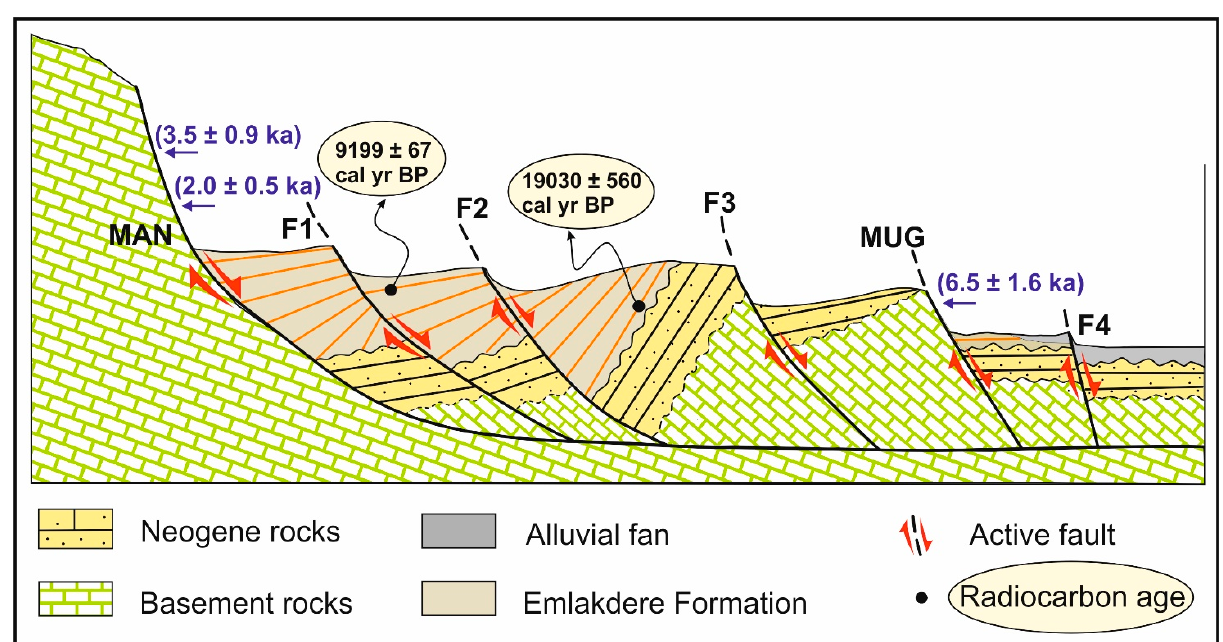
Figure 11. Simplified schematic sketch showing western Manisa Fault Zone and its synthetic faults displacing formations of various ages (Early-late Holocene). Note that in the cartoons the exact horizontal and vertical scales, vertical displacement values as well as thickness of sedimentary layers are disregarded. The approximate lateral distance between MAN and F4 is 400 m. MAN fault depth is 5–10 km at about 10 km northeast of Manisa. MAN: Manastır fault, MUG: Mugırtepe fault. Radiocarbon ages are taken from study of Özkaymak et al. [59], as ca. 19 and 9 cal kyr BP, representing the lowermost and uppermost paleosols within the Emlakdere formation, respectively.